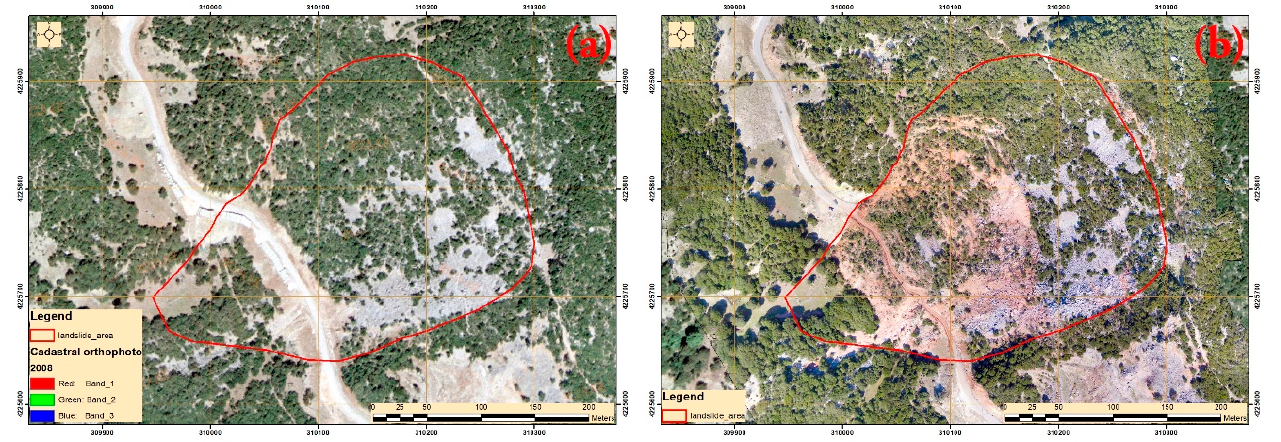
Figure 8. Landslide area. ( a ) Orthophoto of Hellenic Cadastre before the landslide. ( b ) UAV orthophoto after the occurrence of the landslide on January 28, 2017.